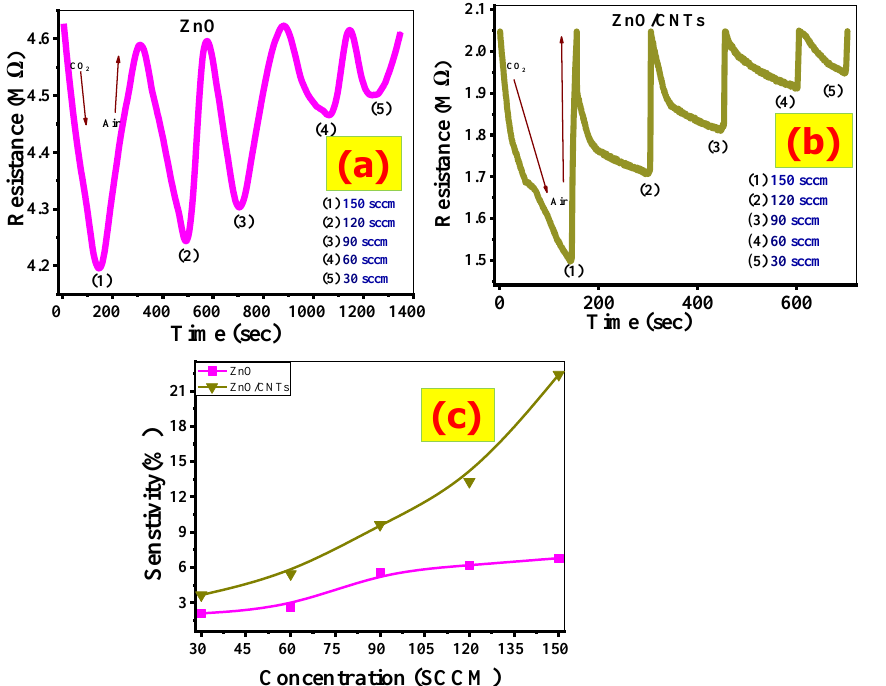
Figure 7. ( a , b ) Dynamic response of ZnO and ZnO/CNTs films, and ( c ) sensitivity.